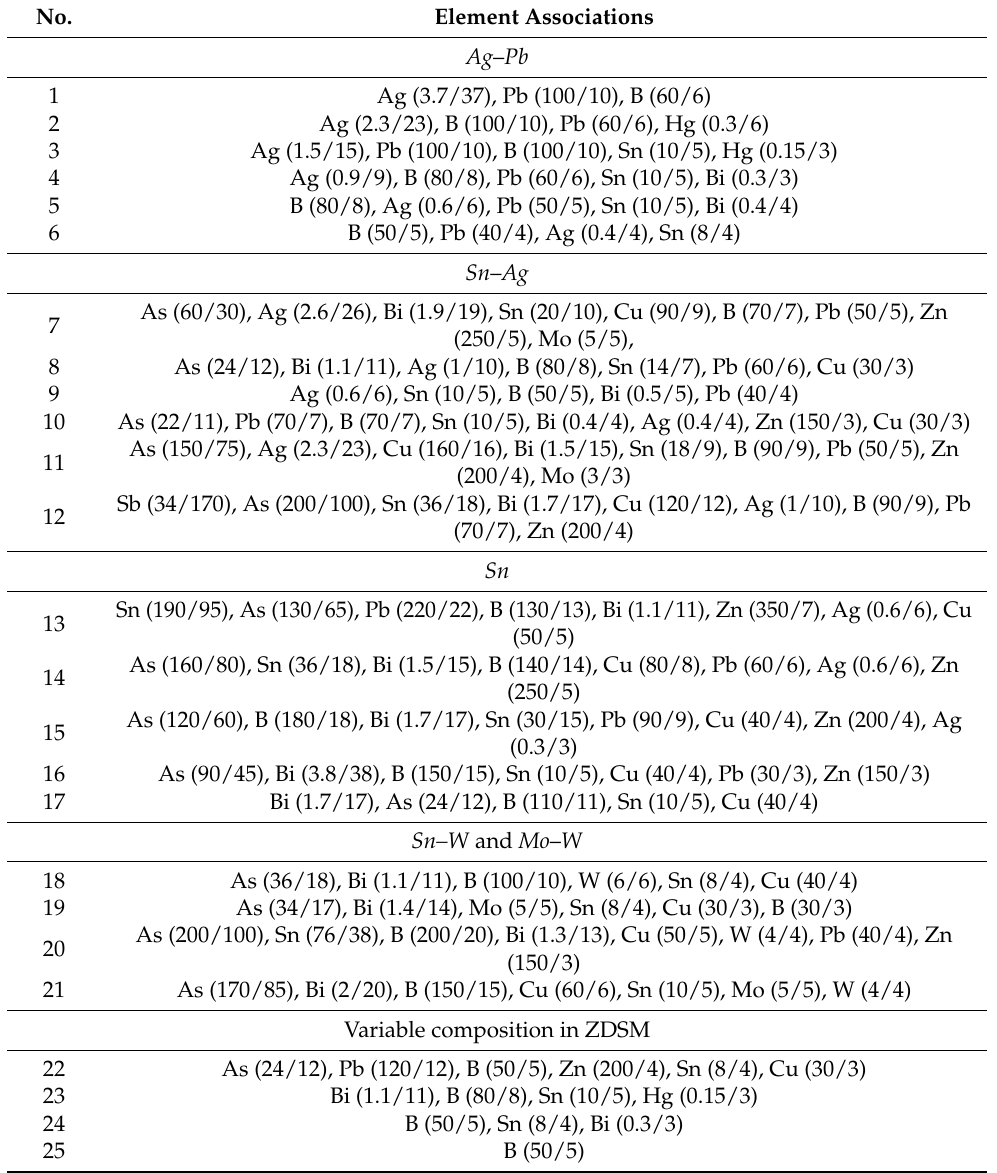
Table 3. The Pestrinsk SBS. Associations of elements (survey of SSs at a 1:50,000 scale). No. Element